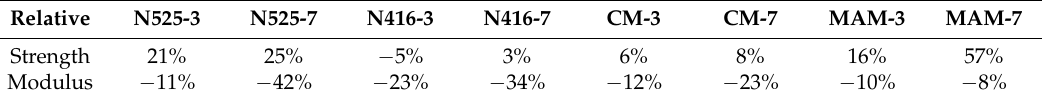
Figure 7. Flexural properties. Strength on the left side (light shaded bar) and modulus on the right (dark bar). Table 3. Flexural properties compared to NC. All differences are significant at 95% confidence level.